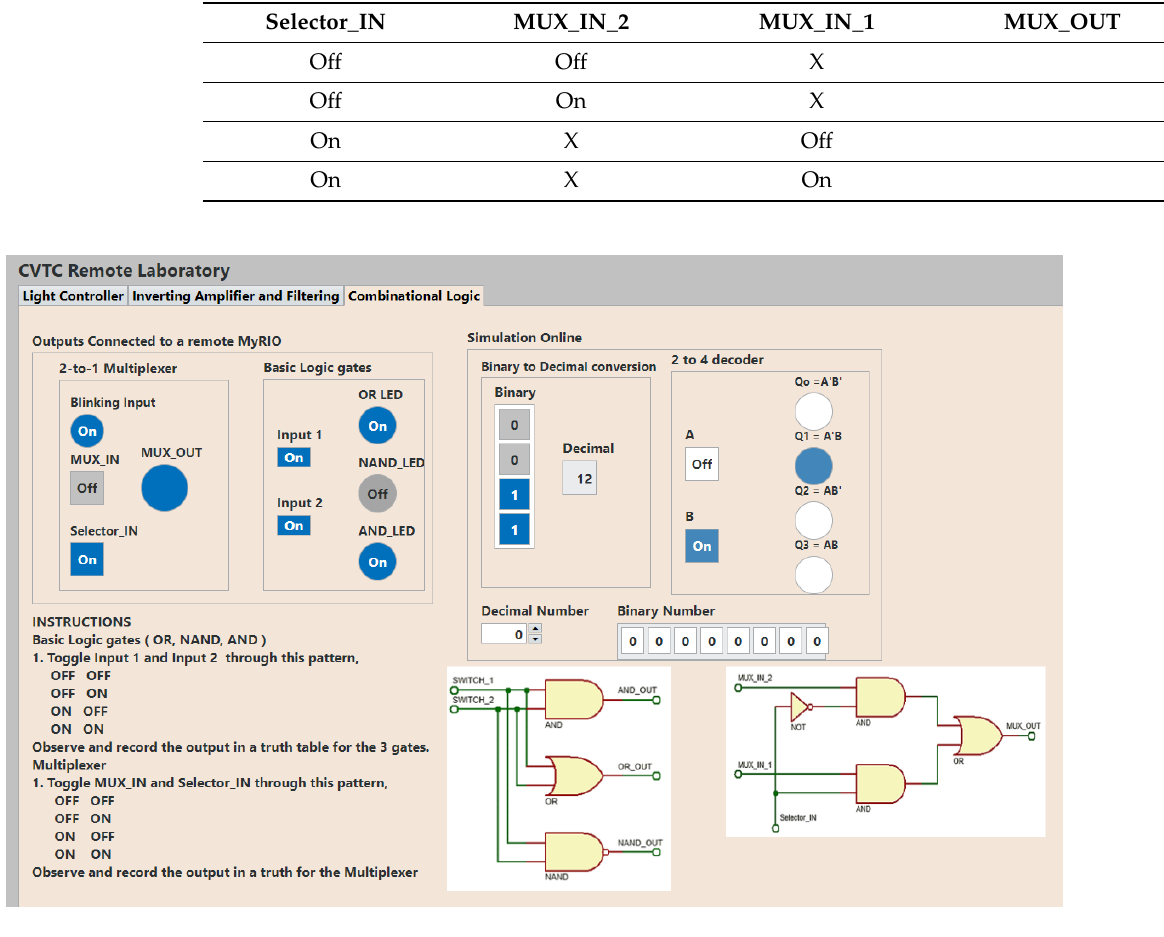
Figure 15. Basic Logic gates and Multiplexer.